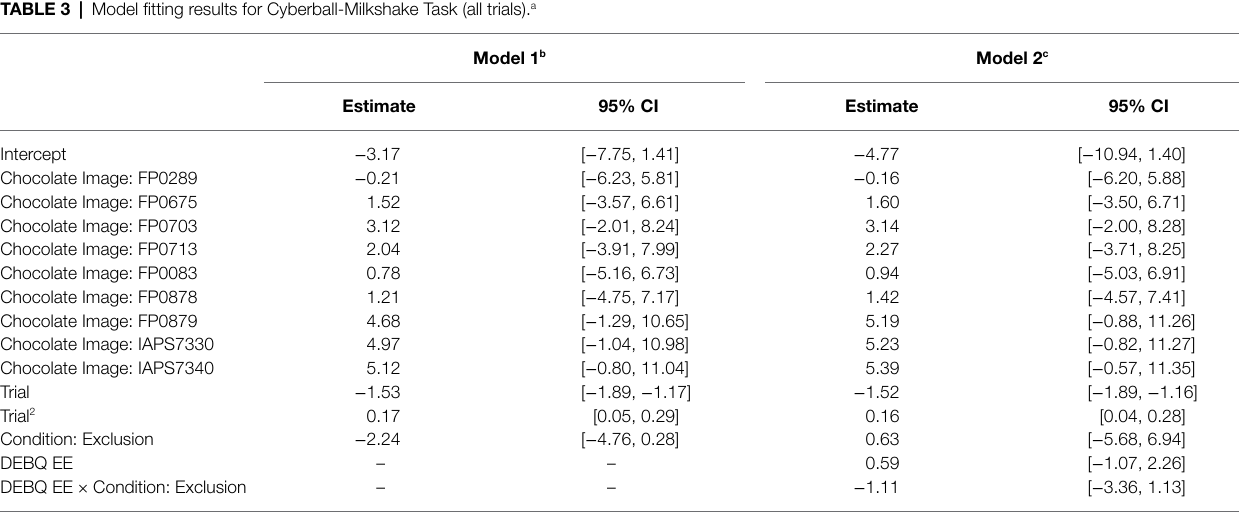
TABLE 3 | Model fitting results for Cyberball-Milkshake Task (all trials).